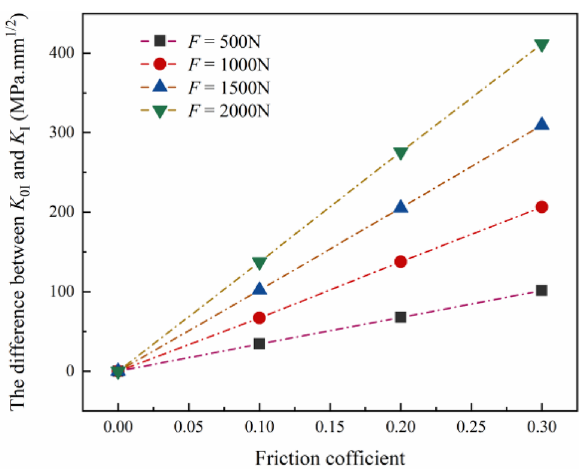
Figure 5. The decrease of stress intensity factor (the difference between the stress intensity factor in the friction-free condition and that in the friction condition) under different load levels varies with the friction